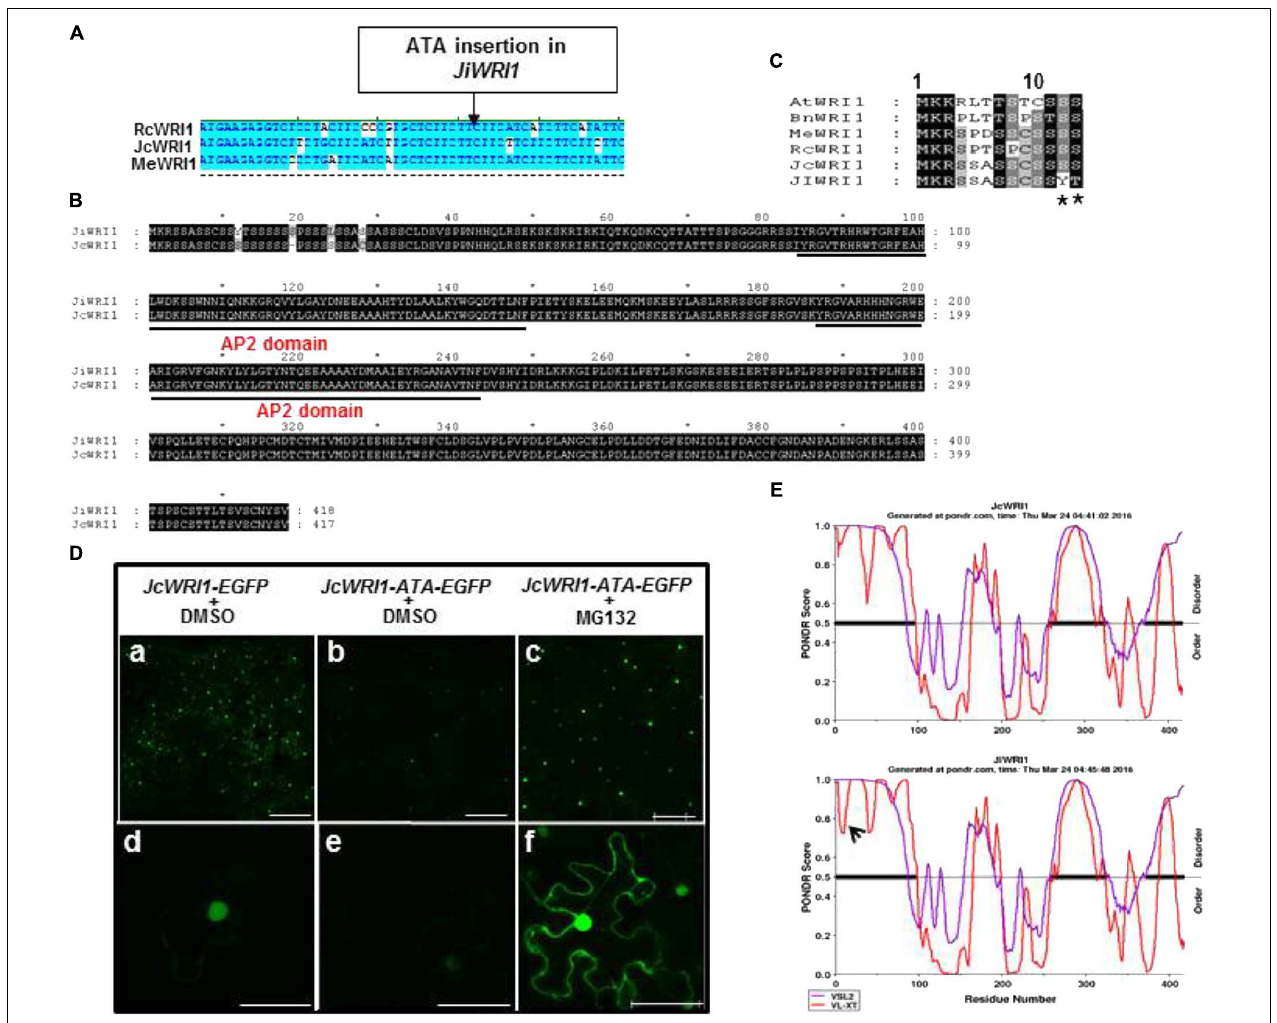
FIGURE 4 | An ATA insertion in the conserved region of JiWRI1 reduces JiWRI1 protein accumulation. (A) Alignment of JcWRI1 nucleotide sequences with its Euphorbiaceae homologs: Jatropha curcas ( Jc ), Ricinus communis ( Rc ), and Manihot esculenta ( Me ). The ATA-insertion site for WRI1 of J. integerrima was indicated. (B) Alignment of complete JcWRI1 and JiWRI1 amino acid sequences. Underlined regions were DNA binding AP2 domains. (C) Alignment of N-terminal amino acid sequence (1–13aa) of JcWRI1, JiWRI1 and other WRI1 homologs. Arabidopsis thaliana ( At ), Brassica napus ( Bn ), Manihot esculenta ( Me ), Ricinus communis ( Rc ), Jatropha curcas ( Jc ), and J. integerrima ( Ji ). ∗ Indicates the mutated amino acid caused by ATA insertion. (D) Confocal images to show protein accumulation of JcWRI1, ATA-insertion mutant of JcWRI1 proteins and the latter treated with MG132. Figures of upper panel (a–c) were magnified in lower panel (d–f) . Bars of upper panel (a–c) and lower panel (d–f) are 250 and 50 µ m, respectively. (E) Protein stability predication and disorder predication for JcWRI1 and JiWRI1 protein using two software (VSL2 and VL-XT) (https://omictools.com/vsl2-1-tool). Arrow indicates the protein disorder caused by the ATA